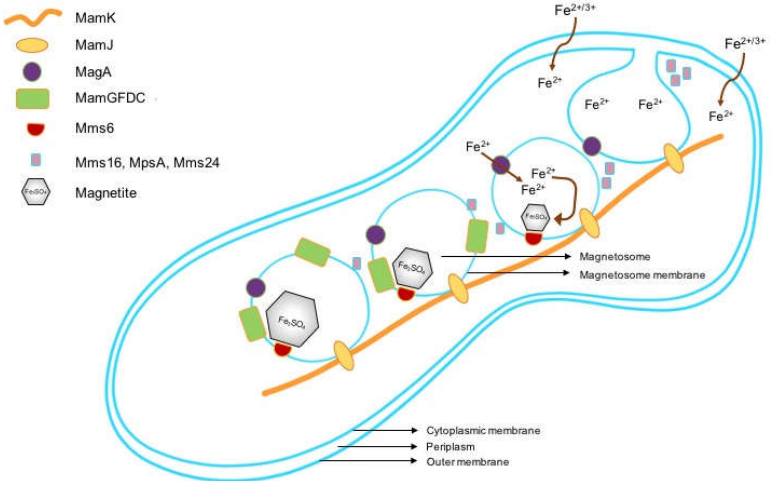
Figure 1. Sequential steps in the formation of magnetosomes in magnetotactic bacteria.